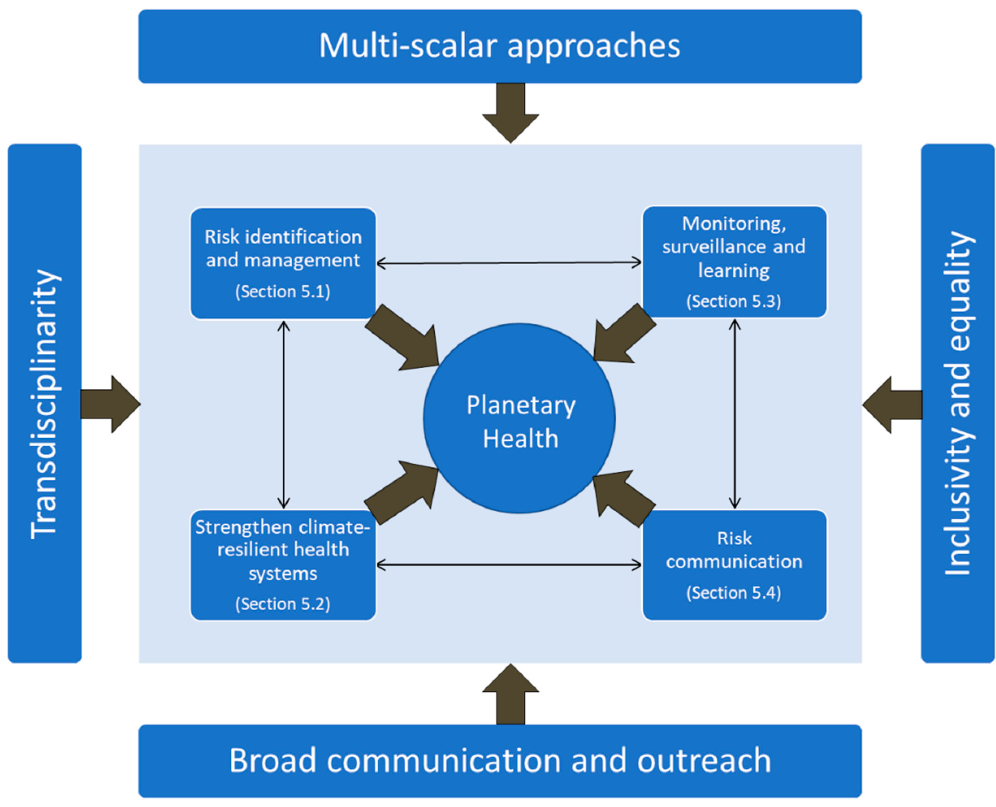
Figure 3. Conceptual framework for Planetary Health proposed for the application of the Health KAN research agenda.